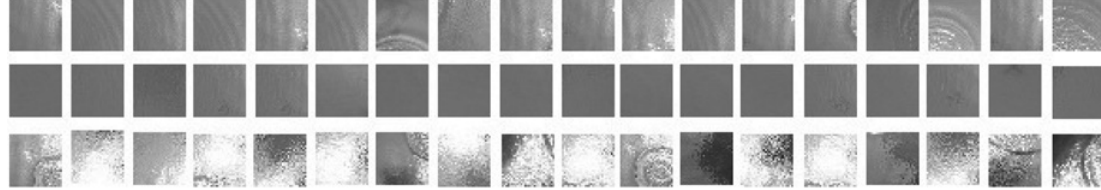
Figure 6: Image patches after binarization processing. First row represents positive samples, second row represents the nega- tive samples and third row represents the